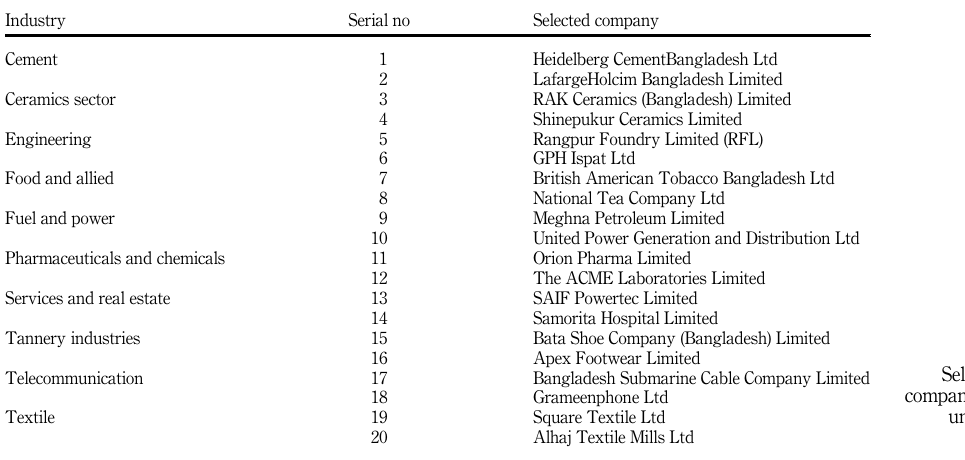
Table A2. Integrated reporting